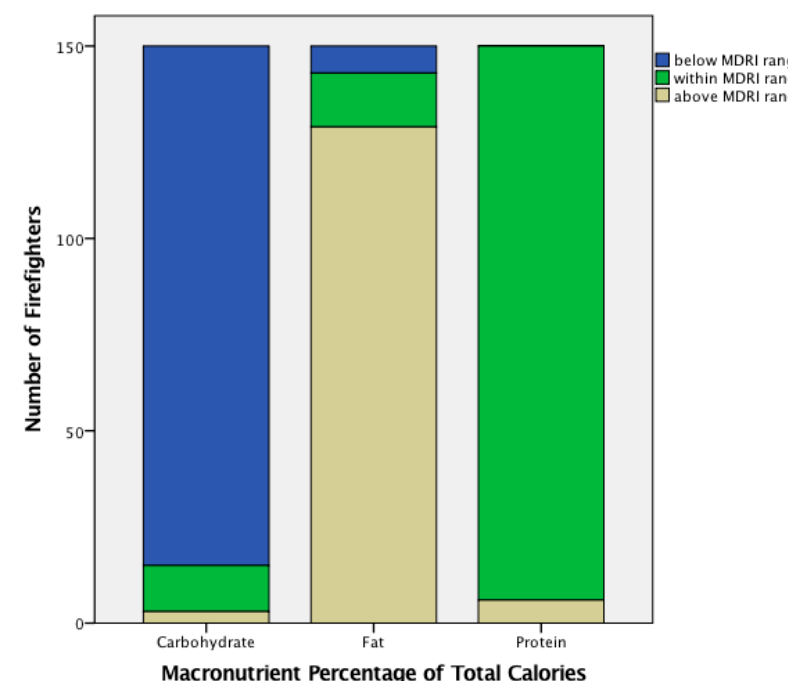
Figure 2. Categorized three-day average for macronutrient intake of firefighters compared to MDRI [2].